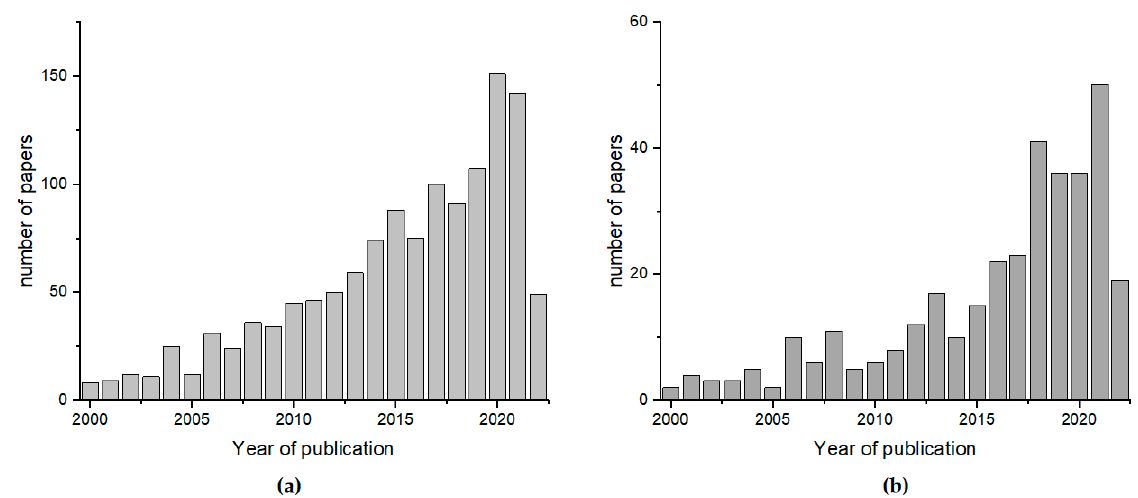
Figure 1. The number of papers published between 2000 and 2022 with the key words ( a ) “honey classification” and ( b ) “honey authentication” according to Scopus (www.scopus.com, accessed on 13 June 2022).